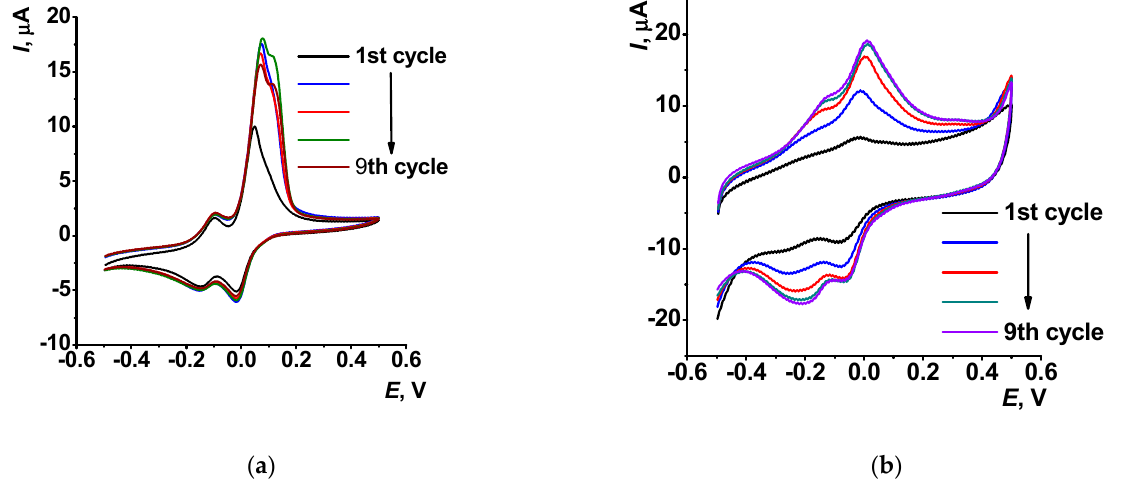
Figure 6. Cyclic voltammograms recorded on GCE ( a ) and GCE covered with CB ( b ) in 0.5 mM methylene green solution, 0.1 M HEPES, 100 mV/s. Odd cycles are shown.